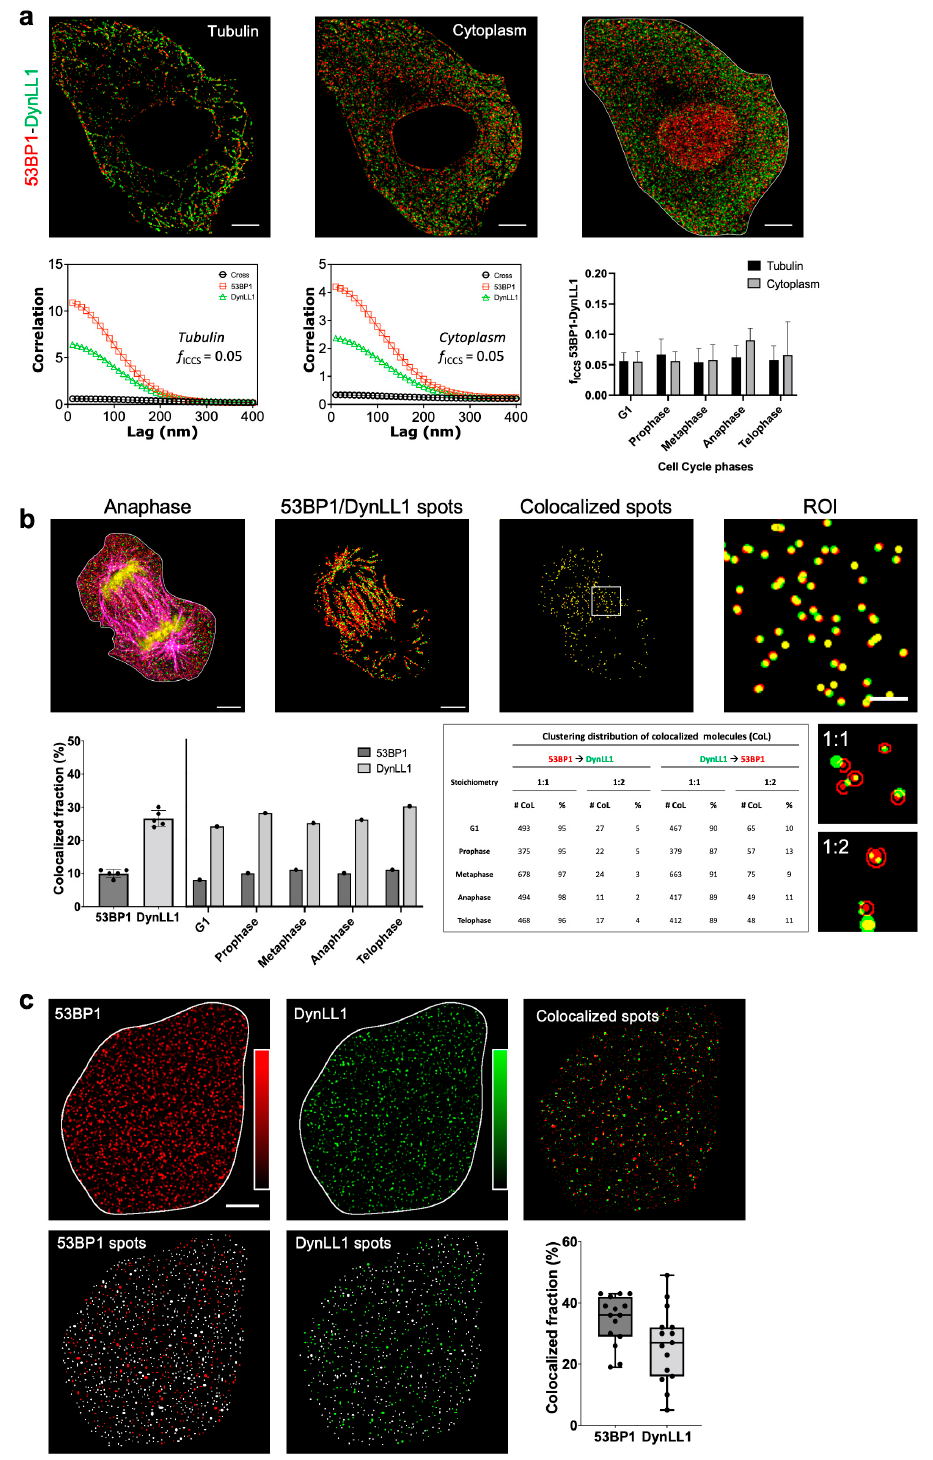
Figure 9. 53BP1 and DynLL1 colocalization analysis of dSTORM ( a , b ) and TIRF ( c ) images of MCF10A cells. ( a ) (Upper row) Dual-color dSTORM image of the protein distributions (from left to right) on the cytoskeleton (tubulin), in the cytoplasm, and in the whole cell. (Lower row) Spatial correlation functions of depicted images recovered by ICCS and colocalized fraction (fICCS) extracted from